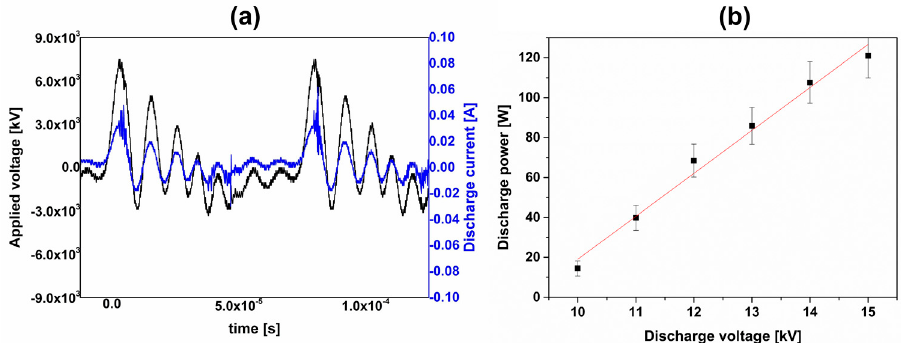
Figure 2. ( a ) Typical IV characteristic of the discharge and ( b ) estimation of the NTP power as a function of the peak-to-peak discharge voltage value from electrical measurements.